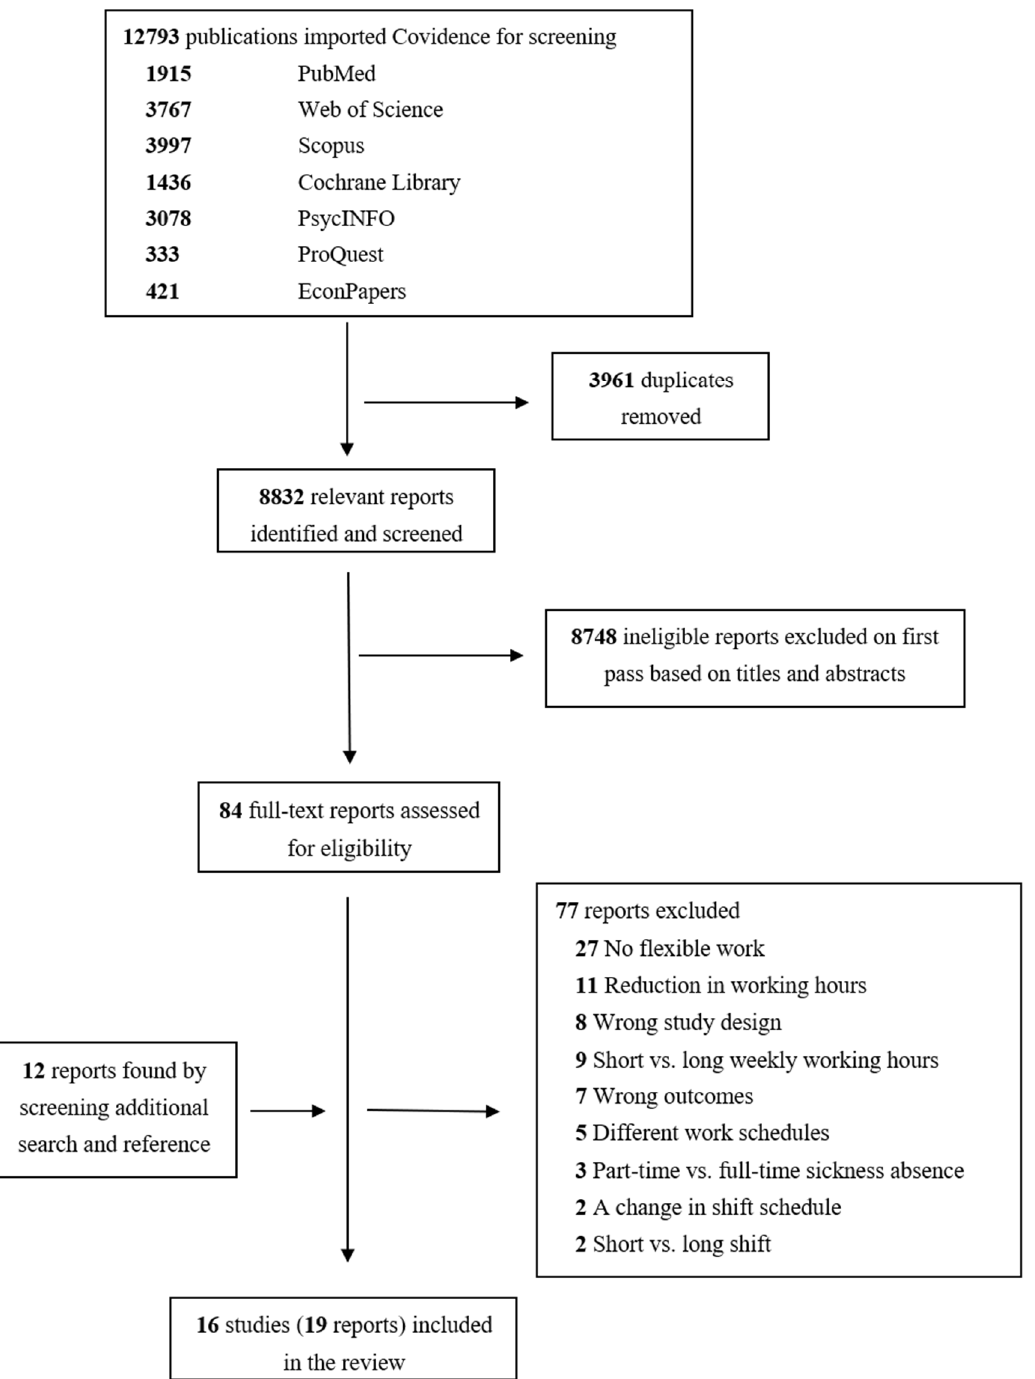
Figure 1. PRISMA flow diagram of the studies selection.